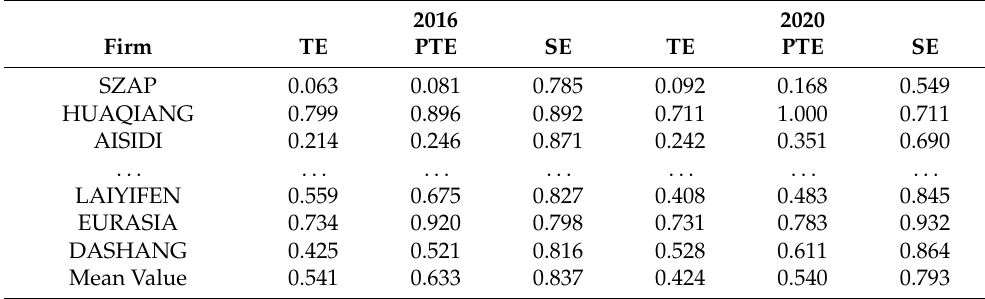
Table A5. Efficiency measurement results of 45 companies that did not use the new retail model.